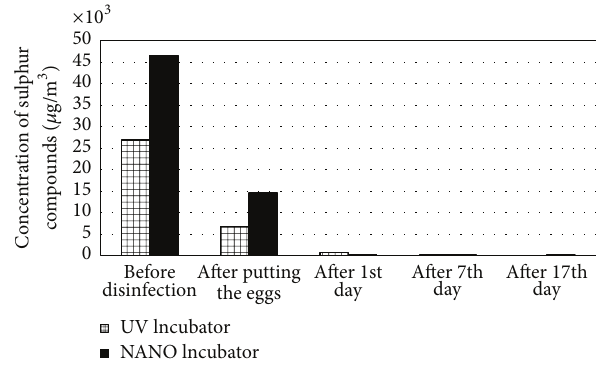
Figure 6: Concentration of sulphur compounds in the air during the incubation [ 𝜇 g/m 3 ].